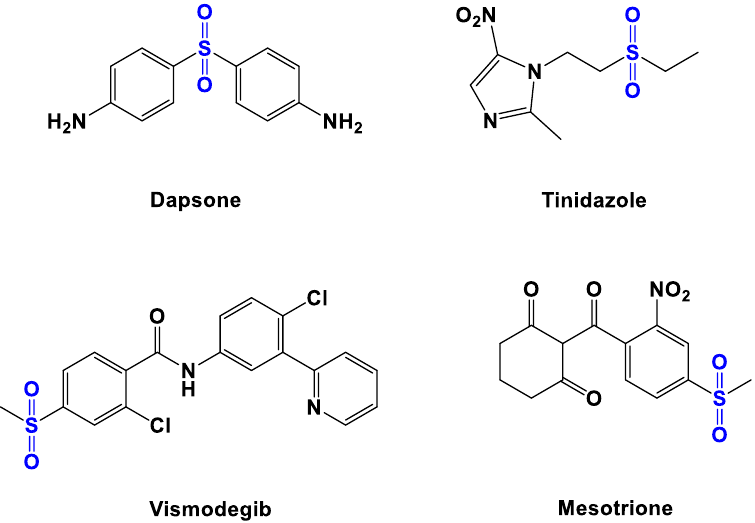
Figure 1. Sulfone containing scaffolds in pharmaceutical